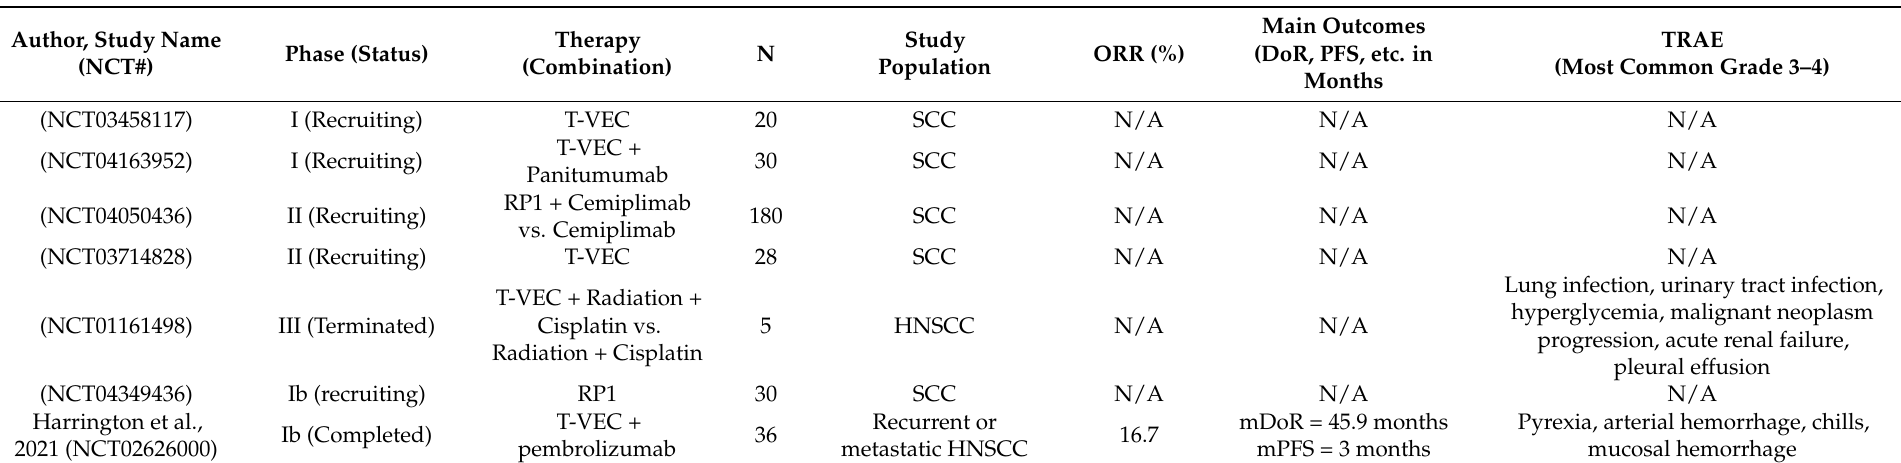
Table 3. Main clinical trials on OV regimens in non-melanoma skin cancers and their reported